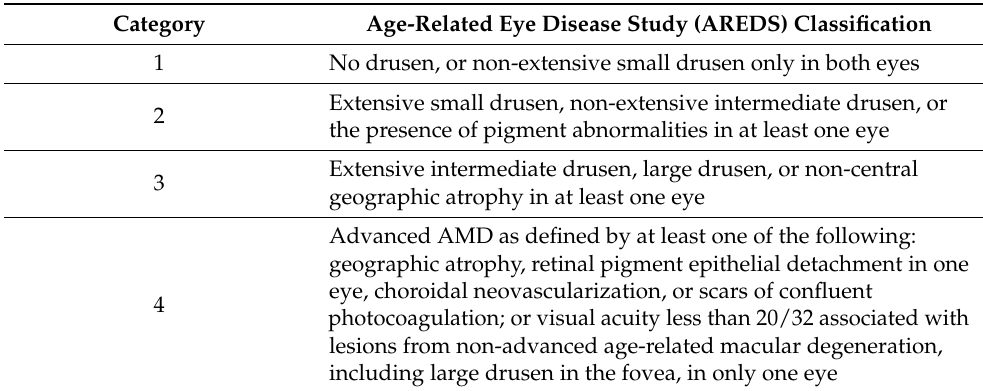
Table 1. AREDS clinical severity scale of age-related macular degeneration (AMD)